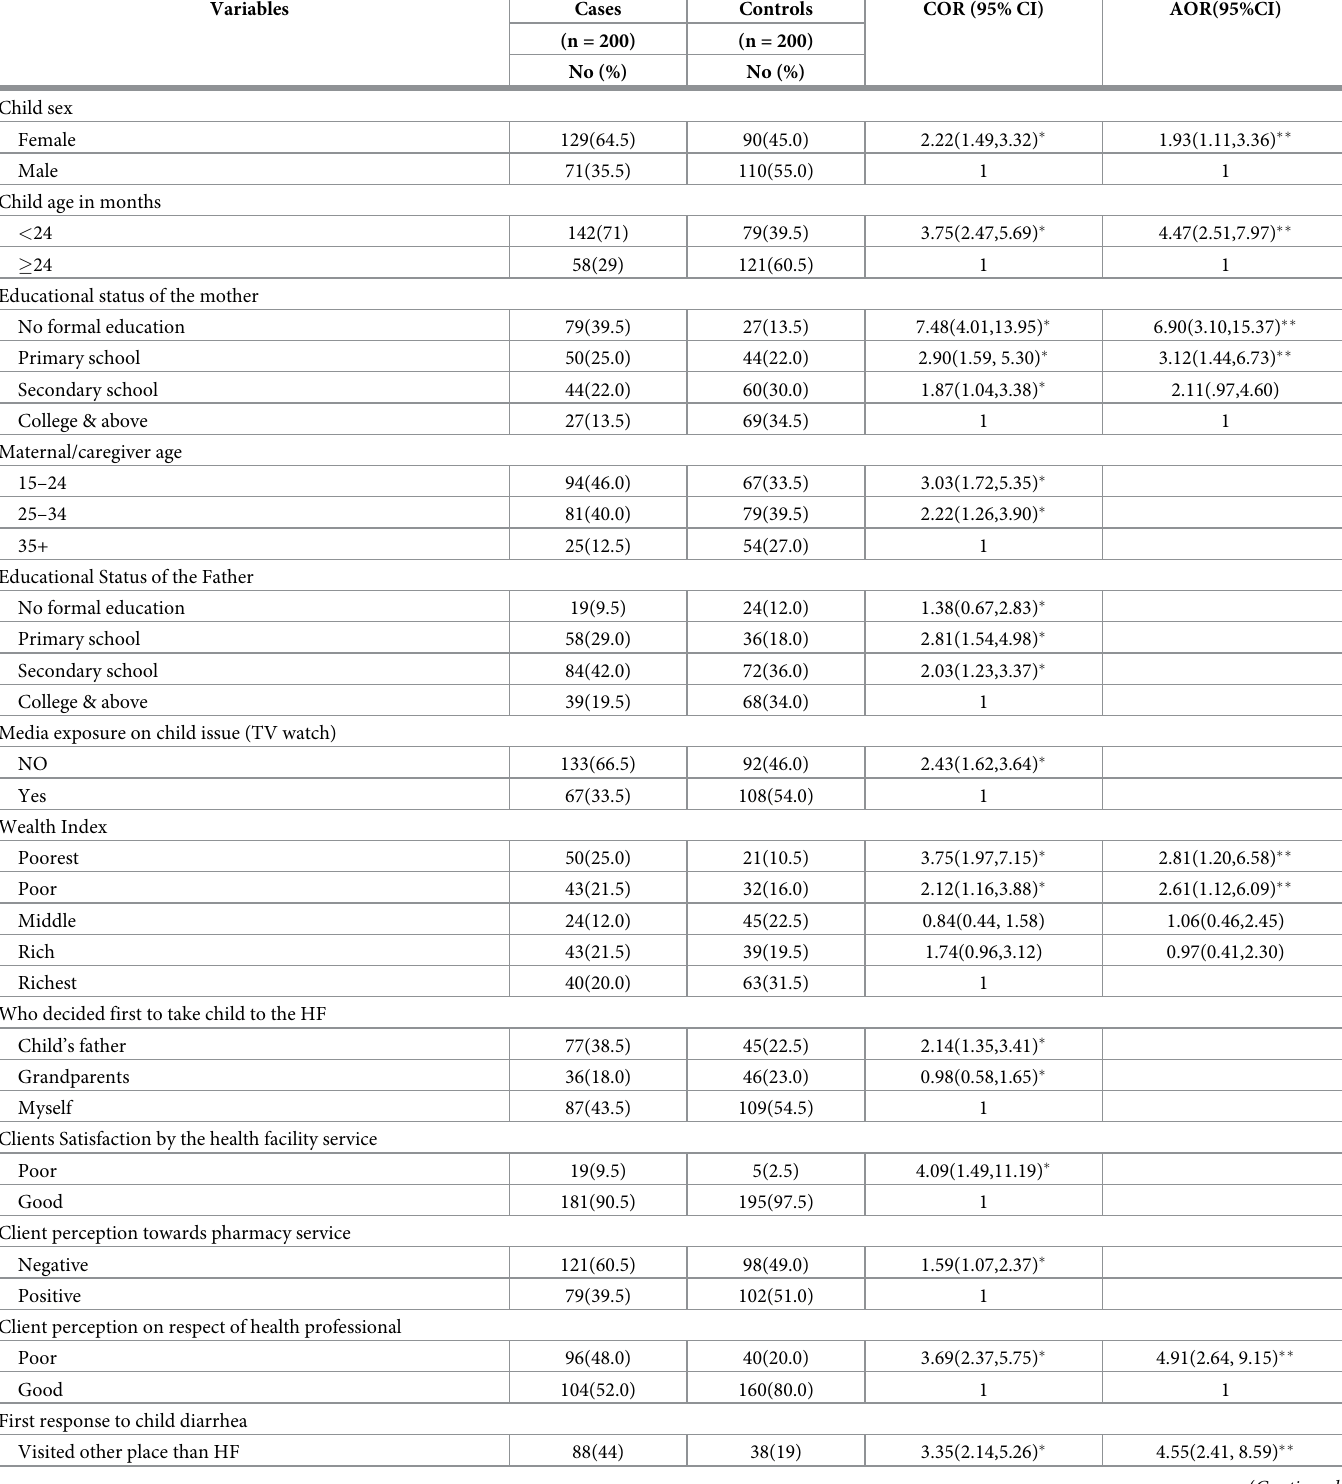
Table 5. Multivariable logistic regression result on determinants of delay in care seeking among mothers/caregivers of < 5-children with diarrheal illness in public health facilities of Arba Minch town, south Ethiopia, 2019 (n =